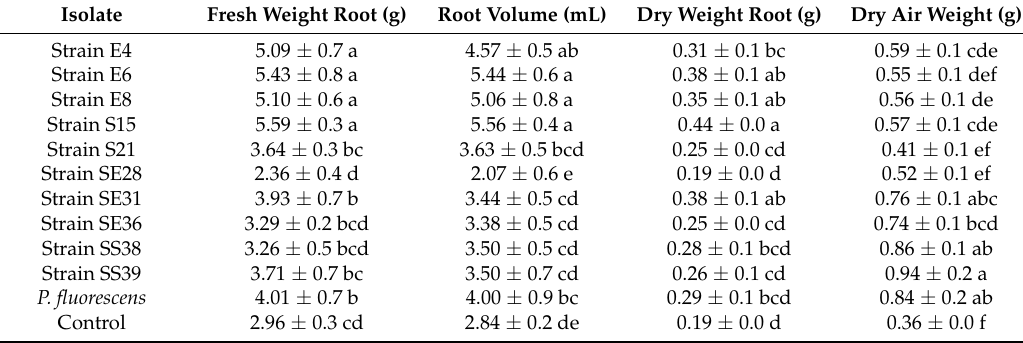
Table 5. Effect on tomato plant growth (dry and fresh root weight, dry air weight and root volume) produced by endophytic bacteria isolated from tomato seeds (E4, E6, E8, S15, S21) and seedlings (SE28, SS38, SS39). Values from the same column followed by a letter in common are not significantly different according to the Tukey test at p ≤